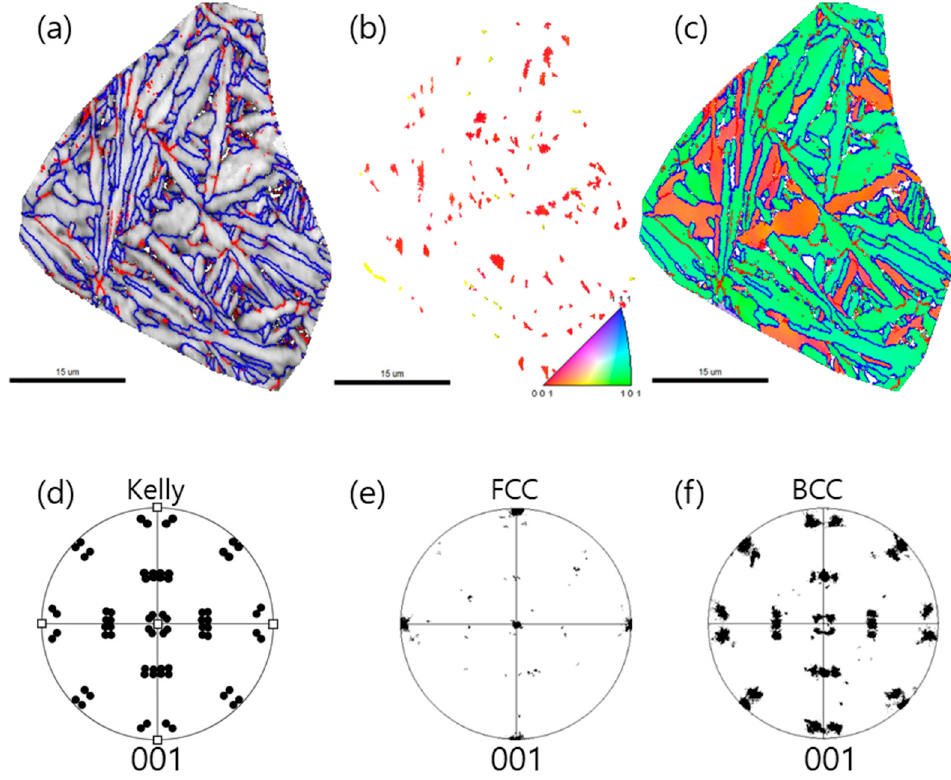
Figure 10. ( a ) IQ map of the region selected from Figure 7 (AT specimen). ( b ) IPF map of FCC phase. ( c ) IPF map of BCC phase. ( d ) 001 pole figure of the Kelly orientation relationship between FCC and BCC. The FCC is marked as squares, and the 24 variants of BCC are represented as circles. ( e ) 001 pole figure of ( b ). ( f ) 001 pole figure of ( c ).